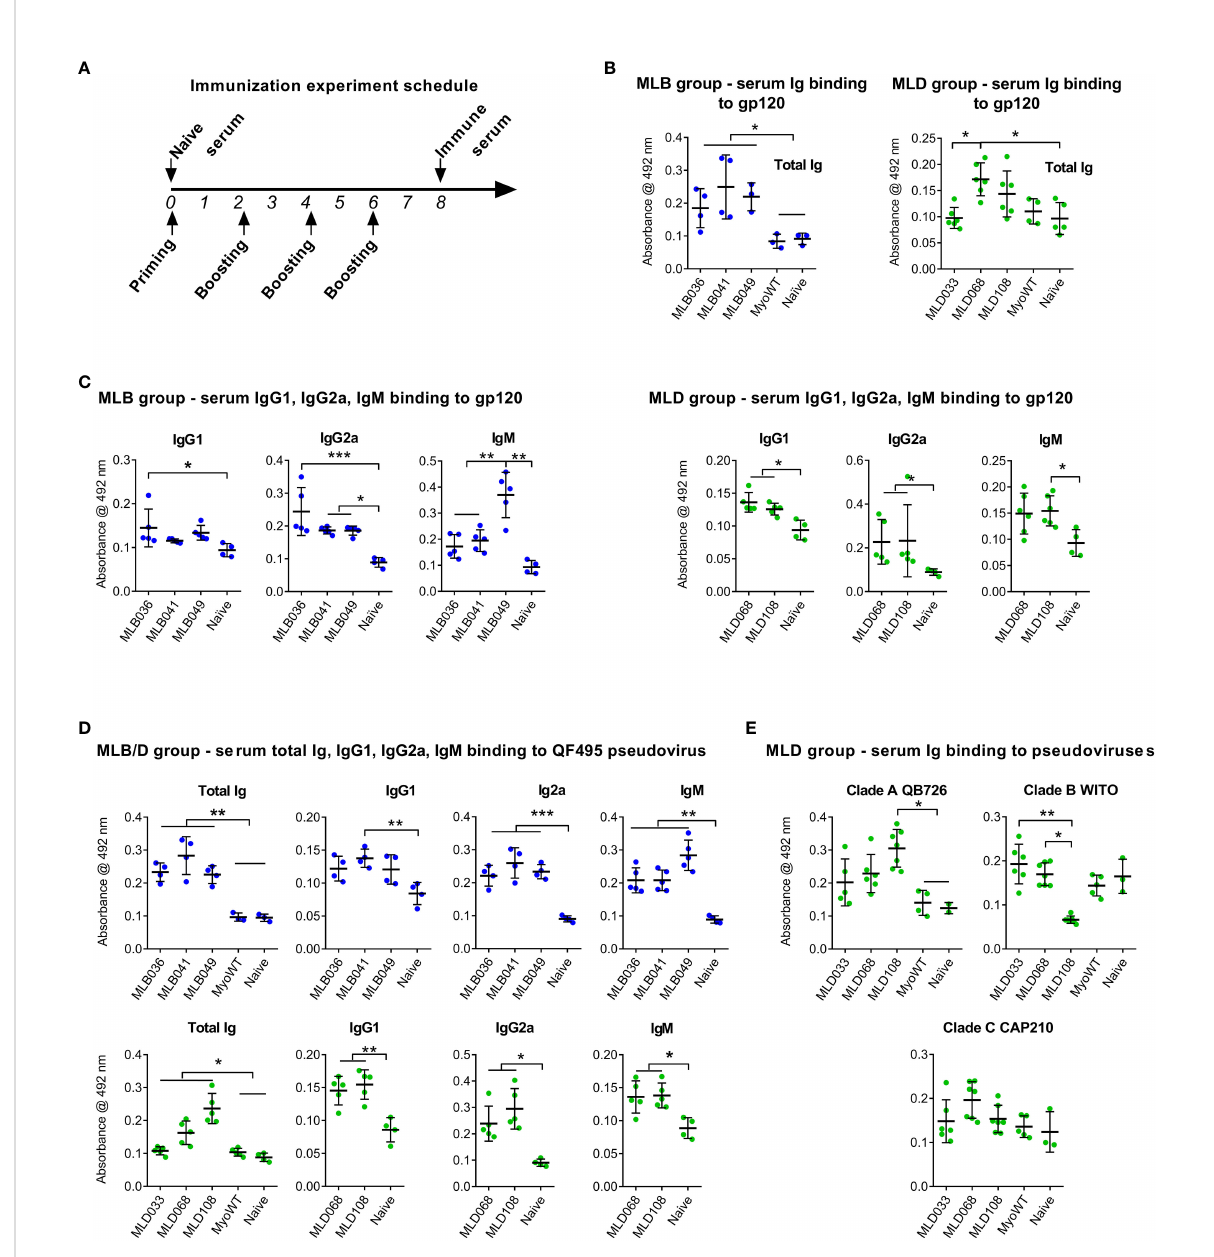
FIGURE 4 MLB and MLD proteins elicited anti-HIV-1 Env serum antibodies. Experimental animals were immunized four times with particular Myomedin variants by intradermal route (A) , sera were collected and tested for binding to multimerizing HIV-1 gp120 clade B (B, C) and selected pseudoviruses (D, E) immobilized on 96-well plates. Antibody titers of IgG (B, E) , IgG1, IgG2a and IgM (C, D) isotypes were measured in ELISA. ANOVA Kruskal-Wallis test with Dunn ’ s post-test (* P < 0.05, ** p < 0.01, *** p < 0.005) was used for statistical signi fi